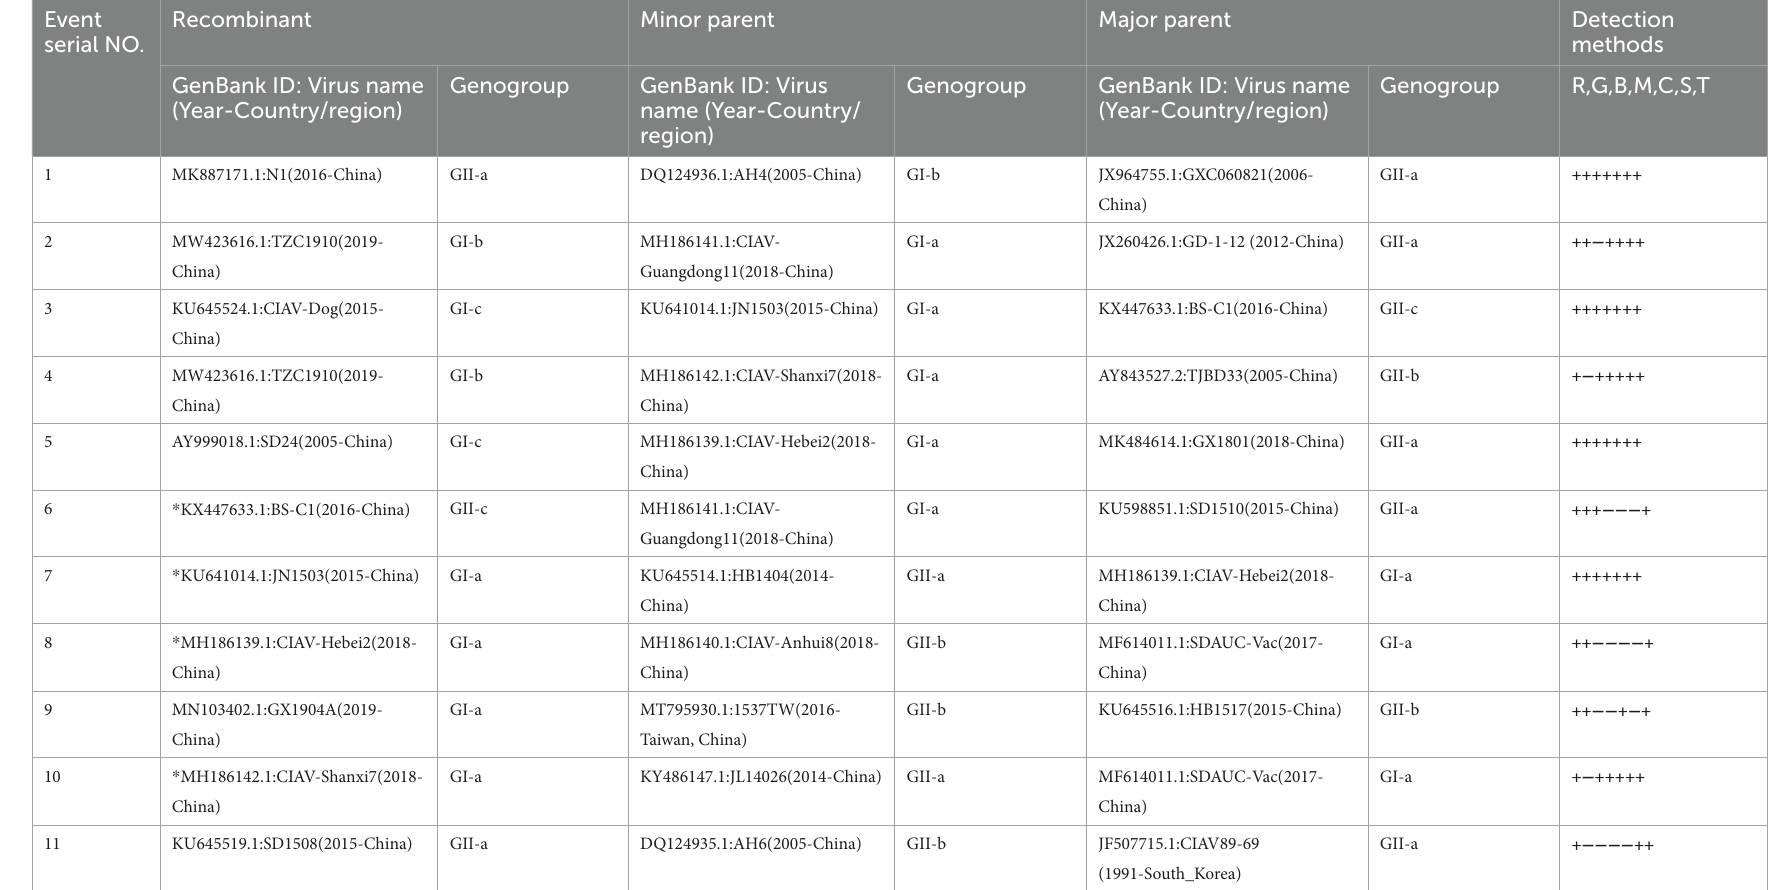
TABLE 2 Identification of 11 potential recombination events in the genome of CAVs isolated during 1991–2020. Event serial